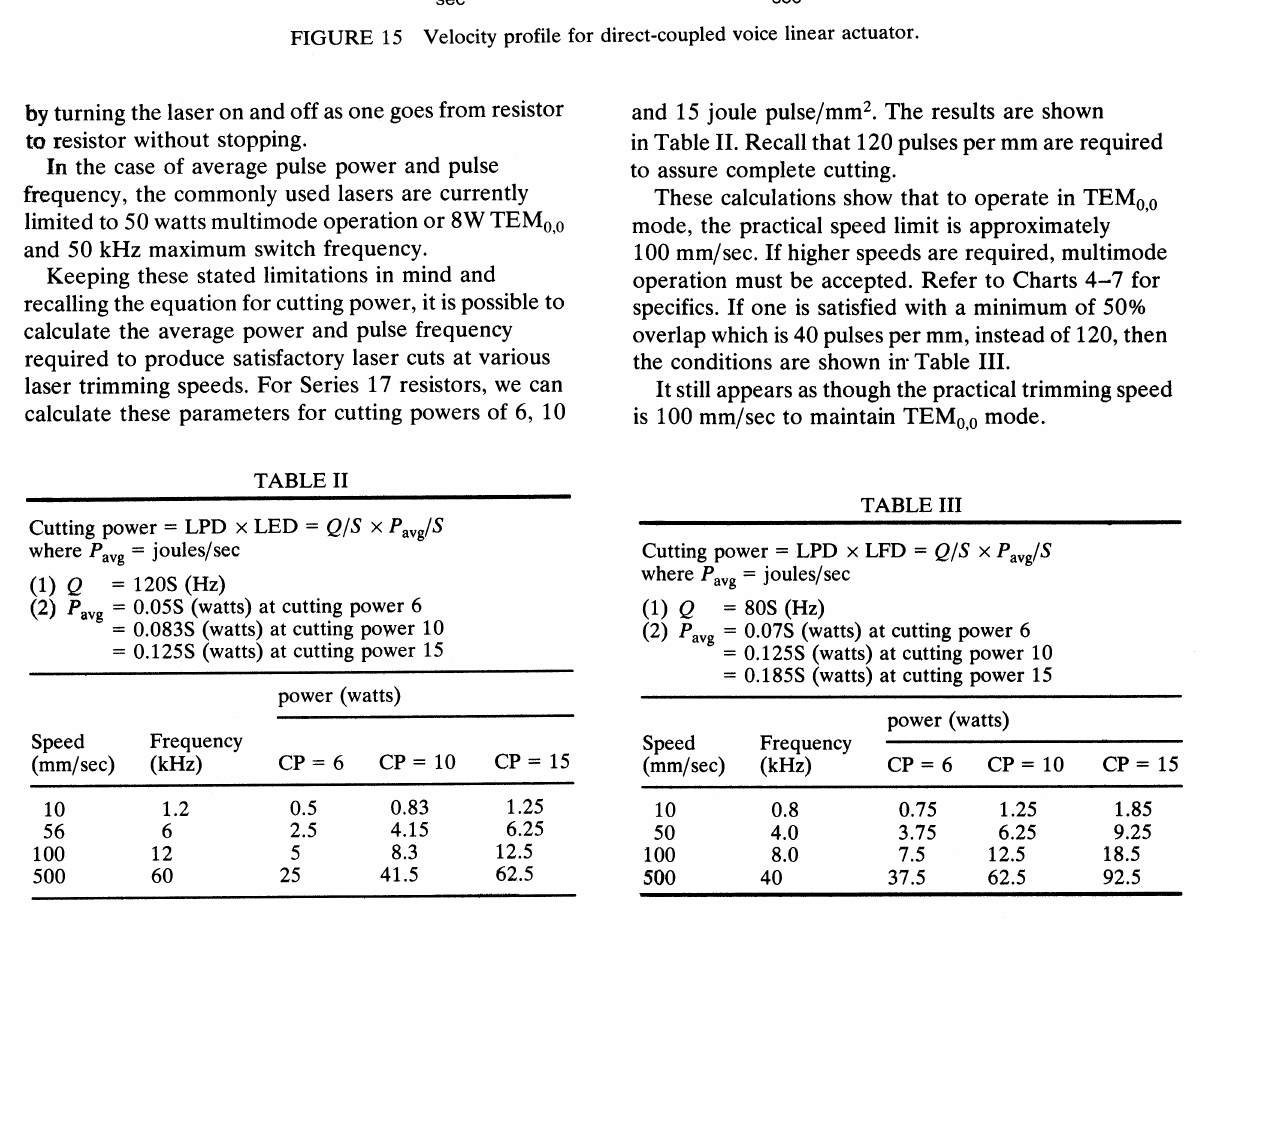
FIGURE 15 Velocity profile for direct-coupled voice linear